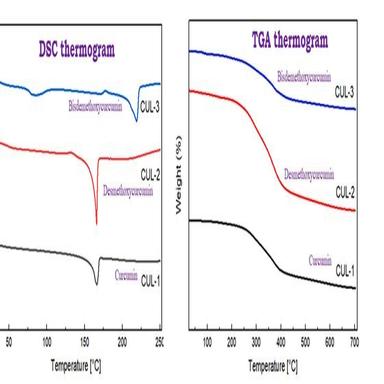
DSC and TGA thermograms of curcumin, desmethoxycurcumin, and bisdemethoxycurcumin.